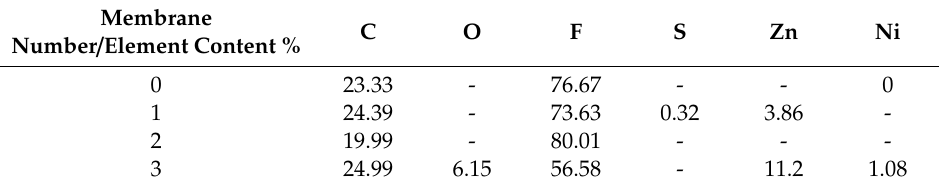
Table 5. Elements and contents of deposits on the membrane outer surface. Membrane